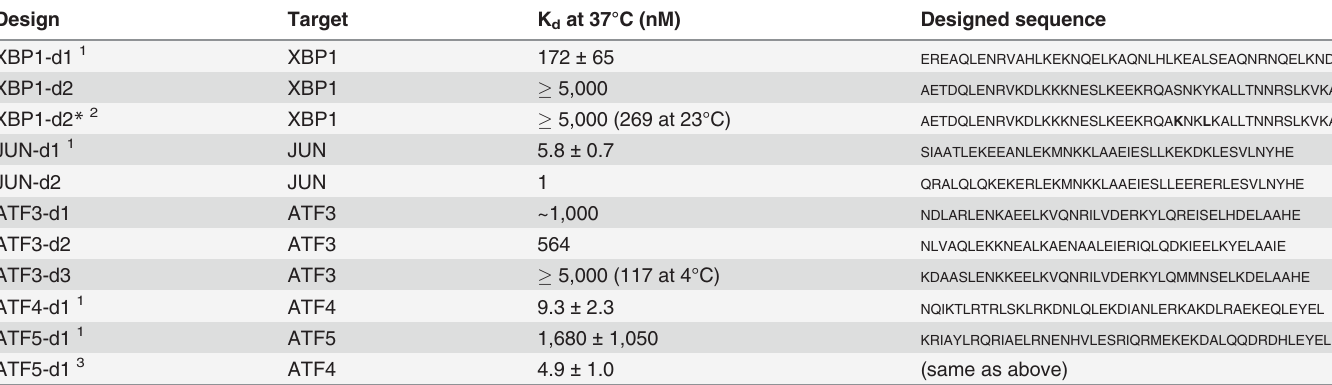
Table 3. Binding of designed peptides to their bZIP targets. Design